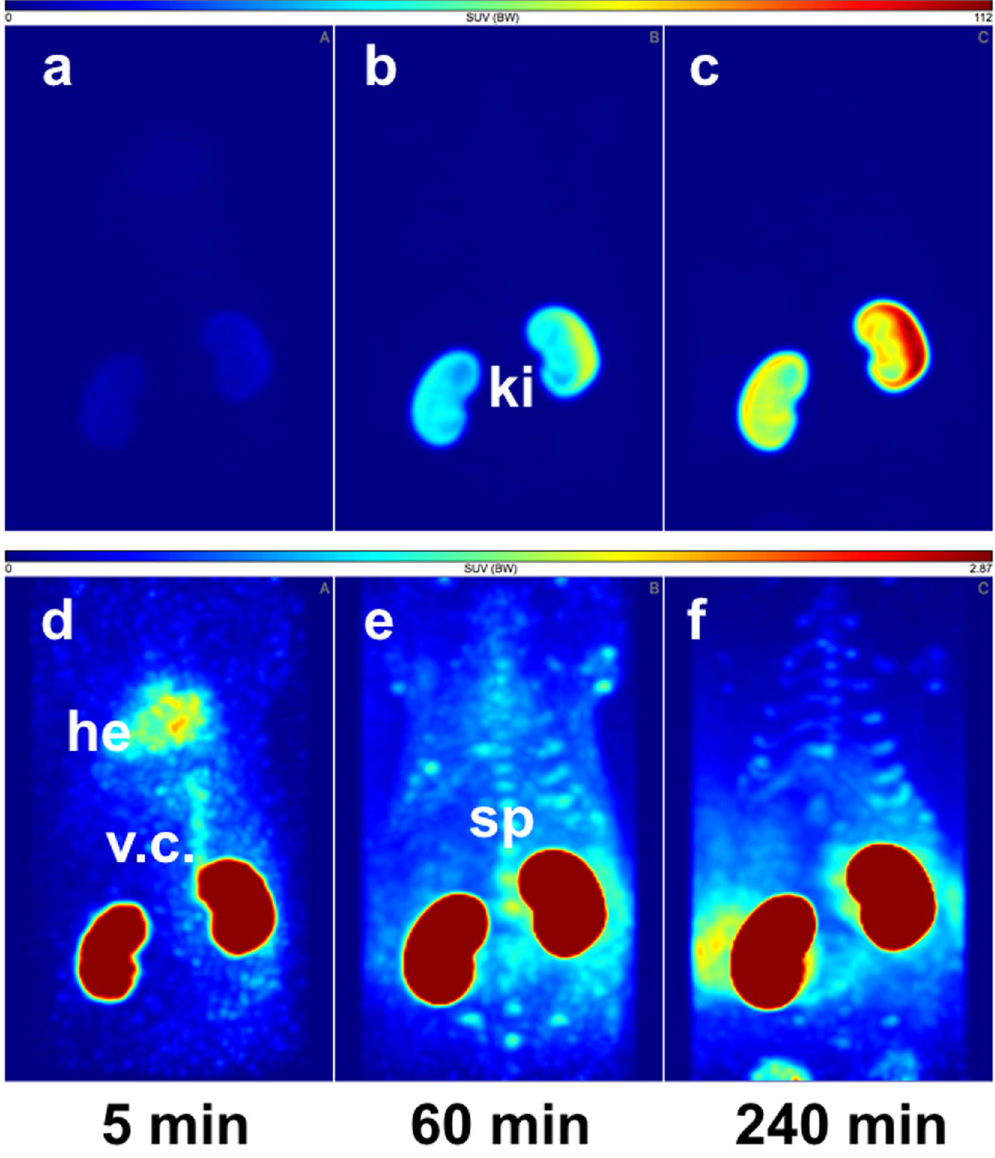
Figure 4. PET-biodistribution after i.v. injection. Maximum Intensity Projections (MIP) of a PET-study with [ 64 Cu]Cu-NOTA-HsTX1[R14A] in a healthy Wistar rat at 5, 60 and 240 min after a single intravenous injection into a tail vein; ( a–c ) images scaled to the maximum intensity SUV 112 g/mL. ( d–f ) Images rescaled to SUV 2.87 g/mL, (ki, kidney; he, heart; v.c., vena cava; sp,